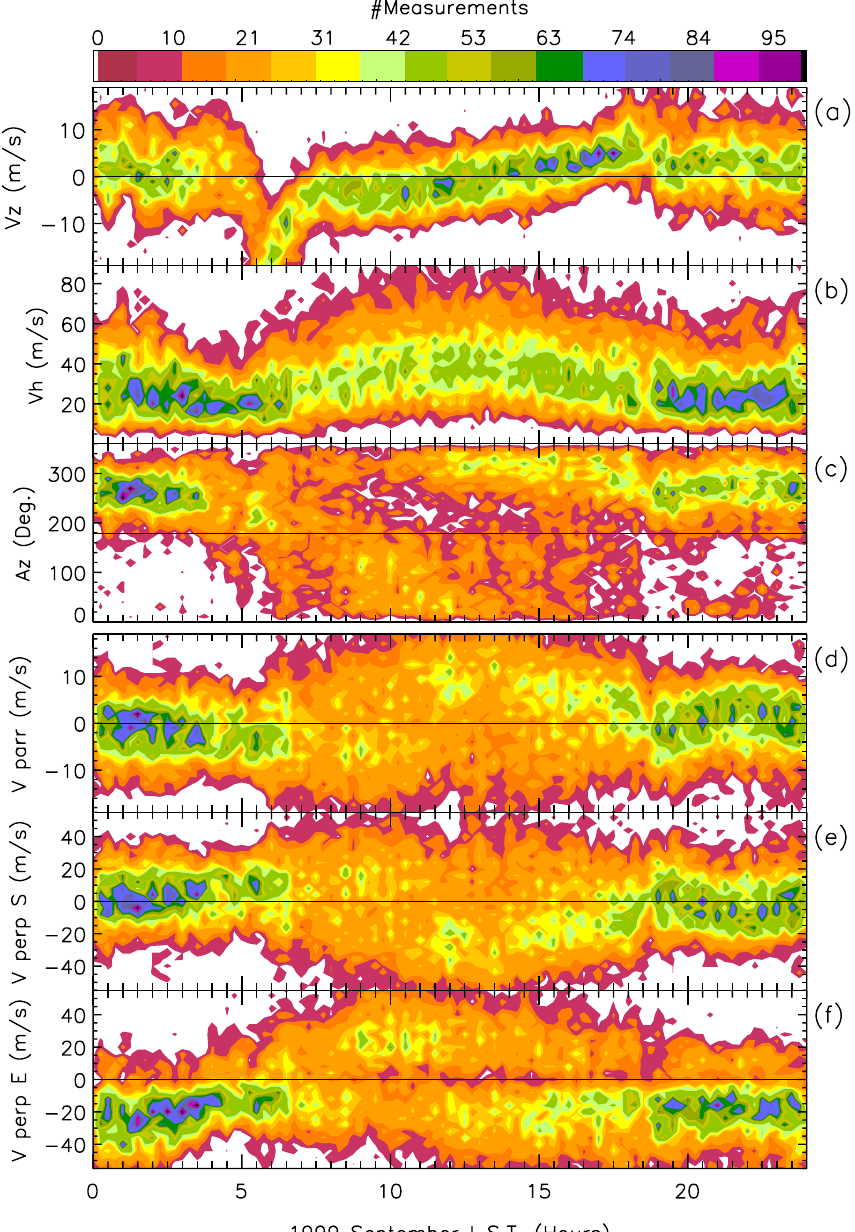
Fig. 2. Mass plot of 56159 indepen- dent Doppler velocities measured us- ing a 40.96 sec integration time during September 1999. The colour scale at the top gives the number of velocities found in each bin of 15 min in LST and using small bin sizes for each ve- locity component. (a ) The vertical ve- locity component, V z , using a bin size of 2 ms − 1 . (b) The horizontal veloc- ity, V h , using a bin size of 5 ms − 1 . (c) The azimuth of the horizontal ve- locity, Az , using a bin size of 10 ◦ . (d) The field-aligned velocity, V k , us- ing a bin size of 2 ms − 1 . (e) The field-perpendicular southward velocity, V ⊥ S , using a bin size of 5 ms − 1 . (f) The field-perpendicular eastward veloc- ity, V ⊥ E , using a bin size of 5 ms − 1 . Tick marks on the abscissa are at 30 min